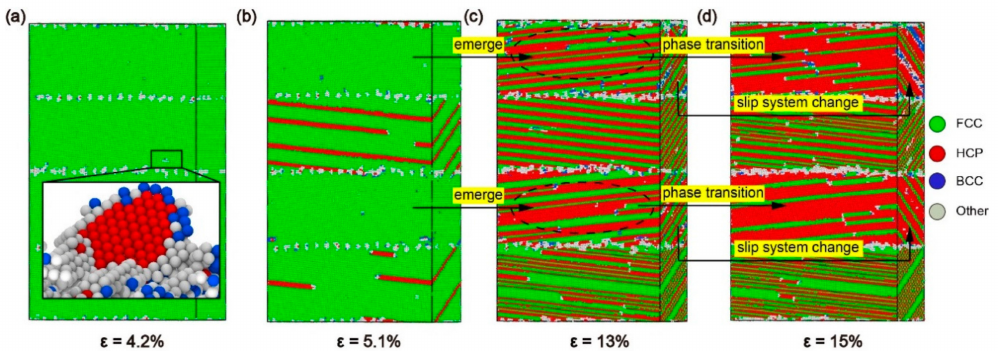
Figure 11. The common neighbor analysis (CNA) of the model with α = 80 ◦ under di ff erent strains ε : ( a ) ε = 4.2%, ( b ) ε = 5.1%, ( c ) ε = 13%, and ( d ) ε =